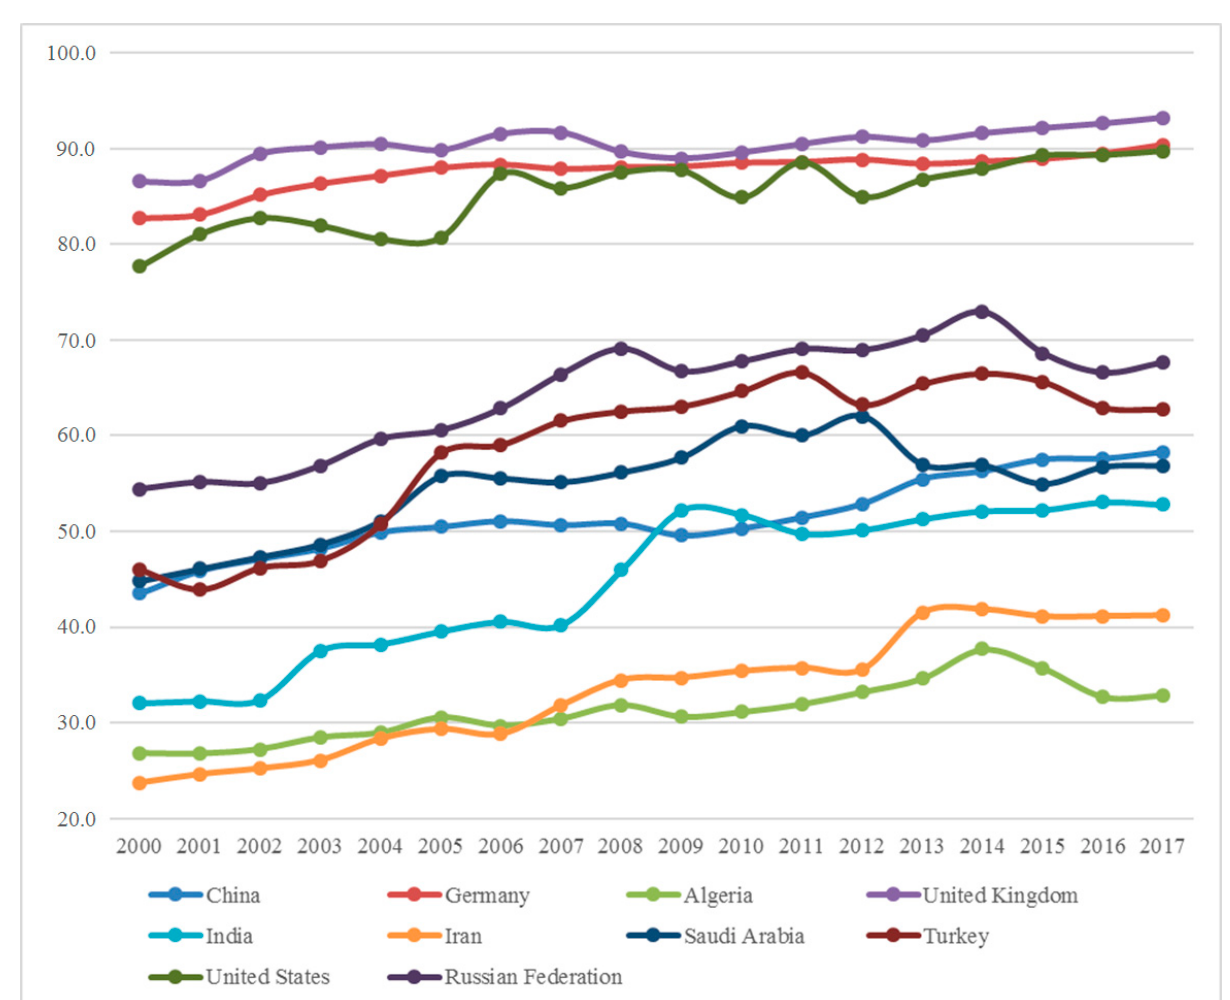
Figure 3. Cultural globalisation processes.